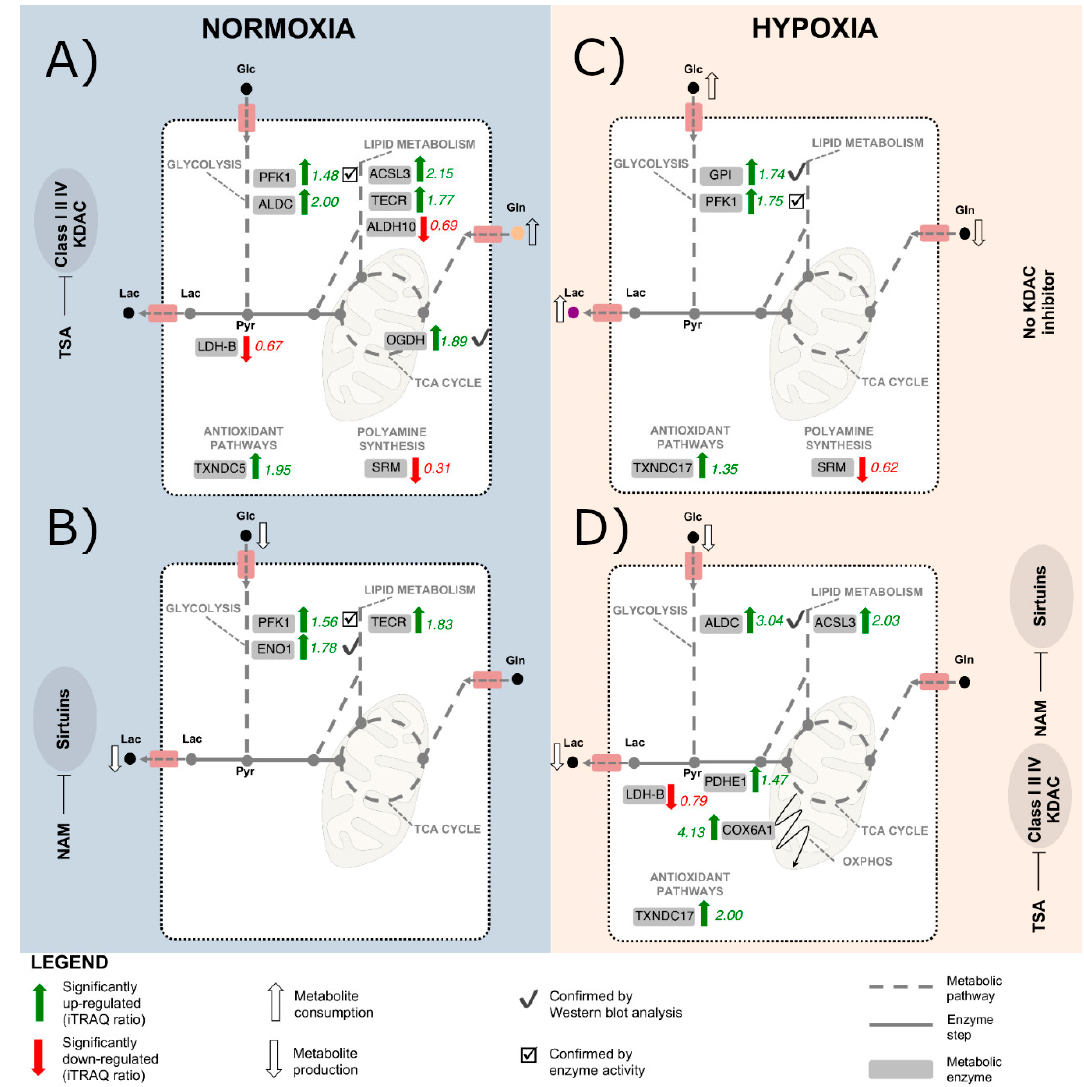
Figure 7. Schematic representation of the dysregulation of metabolic enzymes triggered by TSA and NAM under normoxia and hypoxia in A549 cells. Metabolic pathways are represented with dysregulated enzymes quantified by iTRAQ. Signif- icantly up-regulated enzymes (iTRAQ ratio > 1 and p -value ≤ 0.05) are represented by green arrows. Significantly down- regulated enzymes (iTRAQ ratio < 1 and a p -value ≤ 0.05) are represented by red arrows. Non-significantly dysregulated enzymes are represented by grey arrows. Metabolic dysregulations confirmed by enzyme activities and Western blot anal- yses are represented by check box and check marks, respectively. Downward and upward white arrows indicate signifi- cant changes in metabolite consumption and production rates. ( A ) Metabolic enzyme profile in A549 cells under inhibition of classes I/II/IV KDAC by 1 μ M of TSA for 24 h incubation under normoxic conditions. ( B ) Metabolic enzymes regulation in A549 cells under sirtuin inhibition by 20 mM NAM for 24 h incubation under normoxic conditions. ( C ) Metabolic en- zymes regulation in A549 cells under hypoxic conditions for 24 h incubation. ( D ) Metabolic enzymes regulation in A549 cells under inhibition of both classes I/II/IV KDAC and sirtuins by 1 μ M TSA and 20 mM NAM for 24 h incubation under hypoxic conditions. AcCoA: Acetyl-CoA; ACSL3: Long-chain-fatty-acid-CoA ligase 3; ALDC: Fructose-bisphosphate al- dolase C; ALDH10: Fatty aldehyde dehydrogenase; COX6A1: Cytochrome c oxidase subunit 6A1; ENO1: Alpha-enolase;